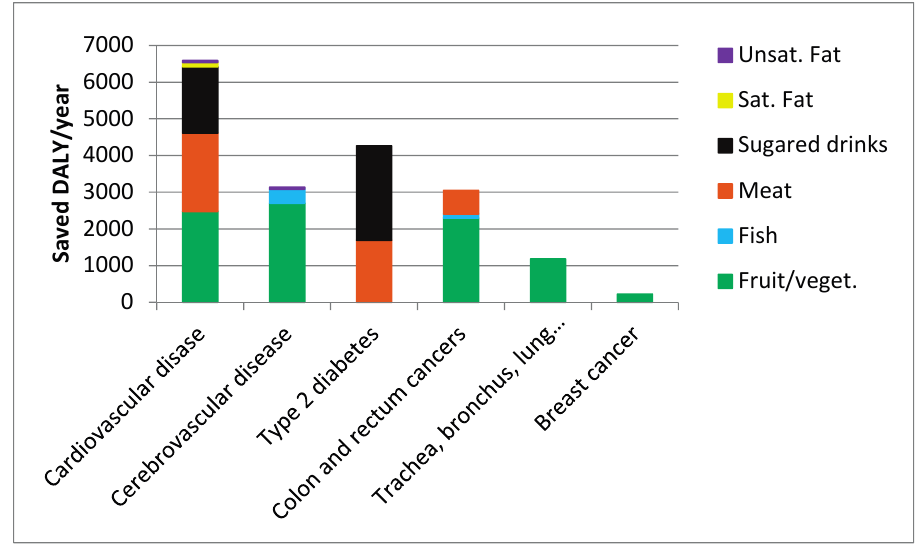
Figure 2. Saved DALY per annum in Denmark from selected diet-related health